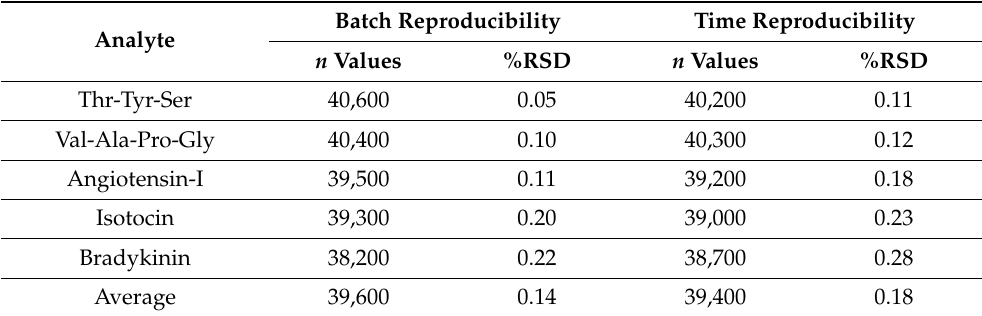
Figure 4. Separation of peptides mixture on C18-bound SM column (1.8 mm × 100 mm) at normal flow rate (100 µL/min) ( B ) and high flow rate (200 µL/min) ( A ); mobile phase: 70/30 ACN/ water with 0.1% TFA. Analytes: 1 (T-T-S), 2 (V-A-P-G), 3 (angiotensin-I), 4 (isotocin), and 5 (bradykinin). Table 3. Batch and time reproducibility of C18-bound SM column (1.8 mm × 100 mm) for peptide separation.